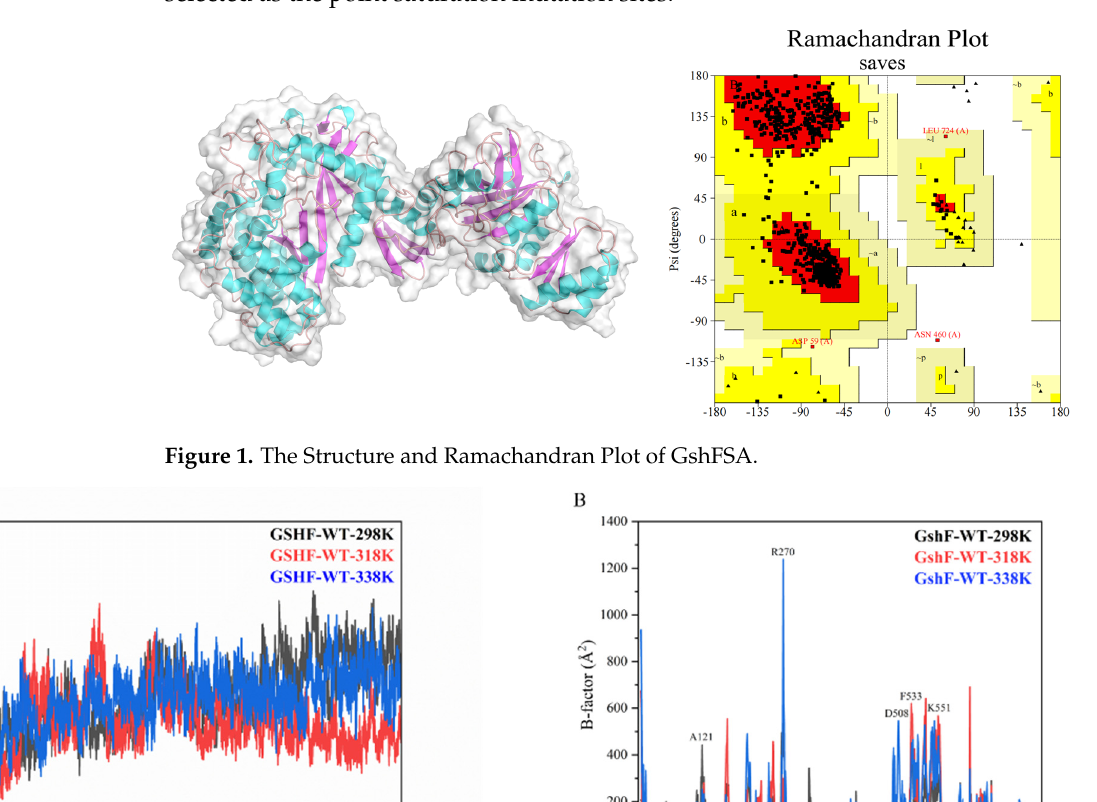
Figure 1. The Structure and Ramachandran Plot of GshFSA.